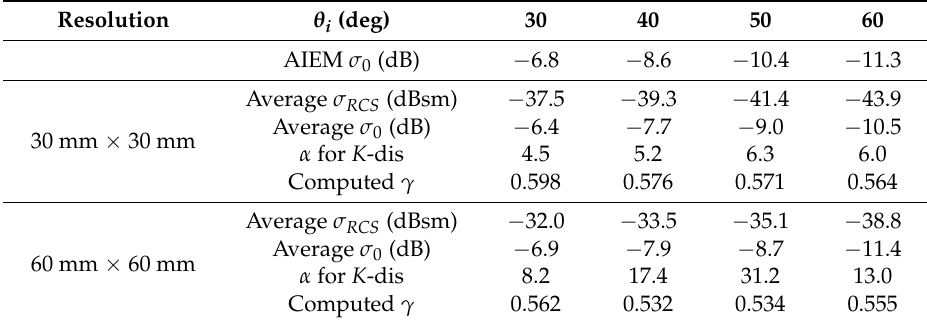
Table 4. Comparisons of the average intensity values and amplitude speckle values from the measured images at the resolution cell size of 30 mm and 60 mm. (Sample parameters shown in Table 1).